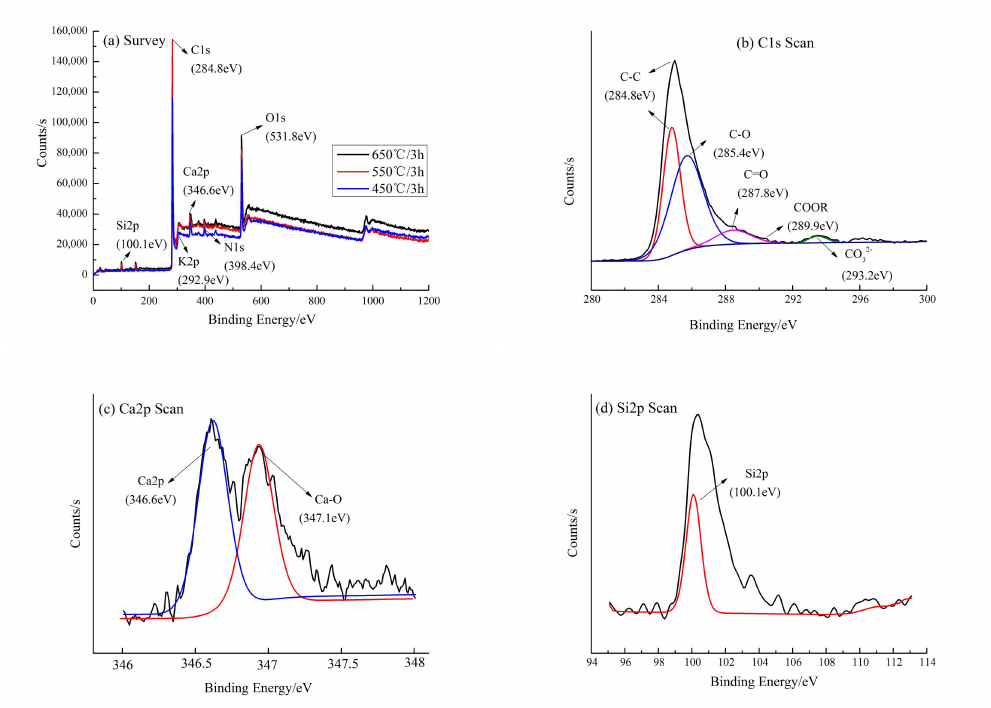
Figure 4. X-ray photoelectron spectra of CB. ( a ) A typical survey scan under di ff erent pyrolysis processes (taking 3 h as an example); ( b ) C1s binding energy at 650 ◦ C / 3 h; ( c ) Ca2p binding energy at 650 ◦ C / 3 h; ( d ) Si2p binding energy at 650 ◦ C / 3